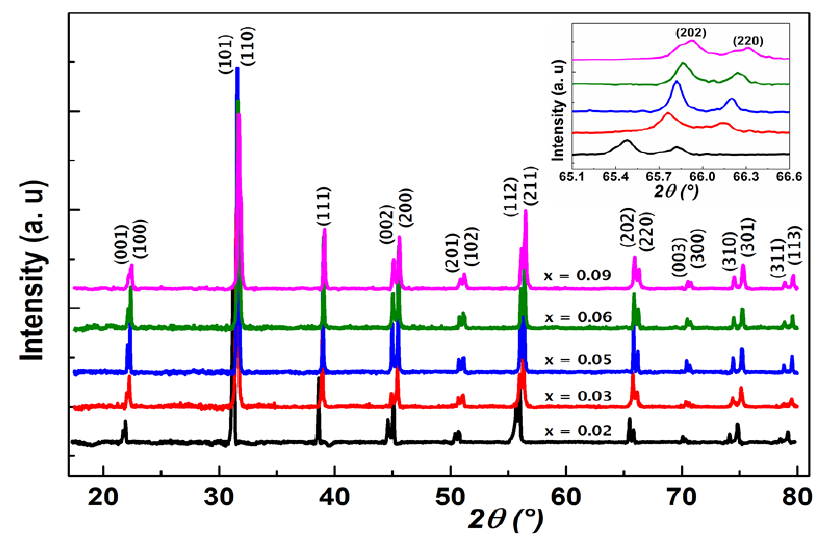
Figure 1. Room temperature X-ray patterns of elaborated compound BTGx (x = 0.02, 0.03, 0.05, 0.06, 0.09). The inset indicates the zoom of evolution of (202) and (220) lines versus Ge-content.